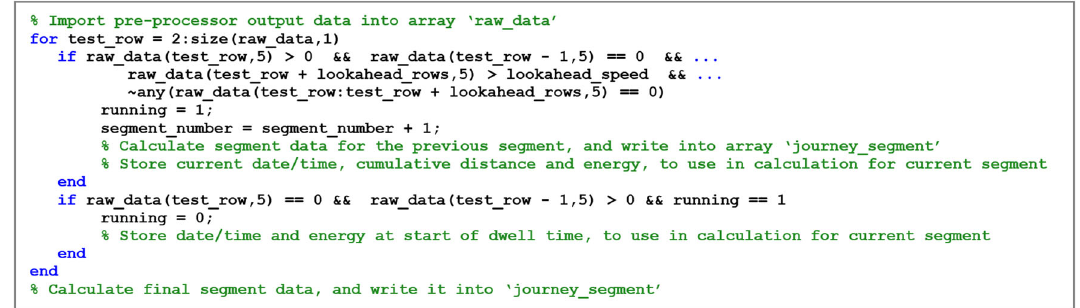
Fig. 2 Pseudocode for the filtering extraction